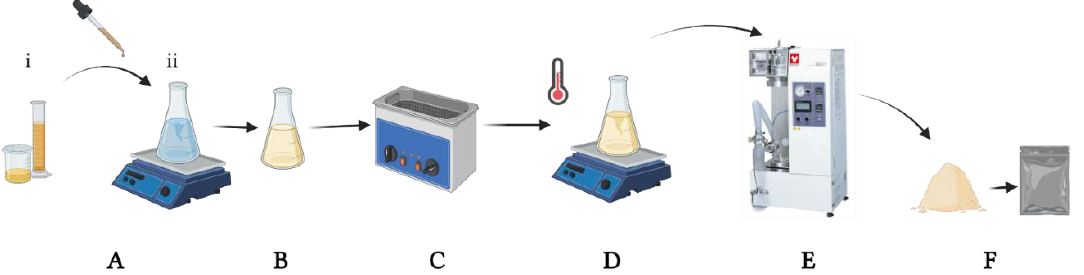
Figure 1. Experimental spray-drying process. ( A ) Quercetin solution (1:5 ethanol: water) (i) was added drop-by-drop to inulin solution (ii). ( B ) Mixed solution, inulin and quercetin homogenization. ( C ) Sonication at 25 °C for 30 min. ( D ) Final solution was agitated and maintained a specific temperature before and during drying. ( E ) Yamato model spray dryer. ( F ) NQs in a dust formulation were stored in dark conditions.